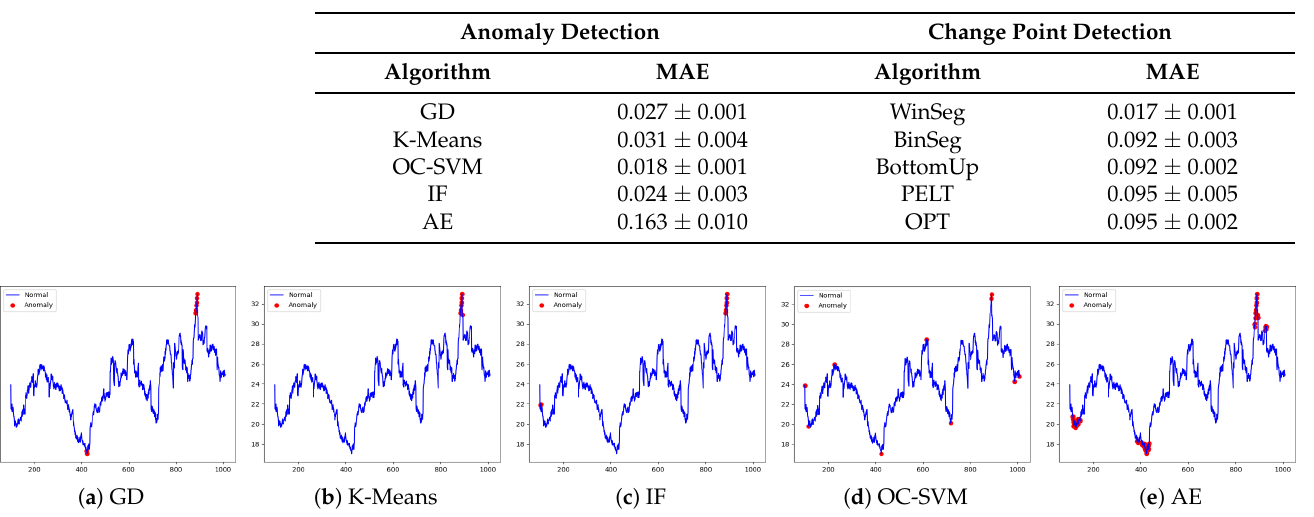
Table 2. Anomaly Detection MAE.